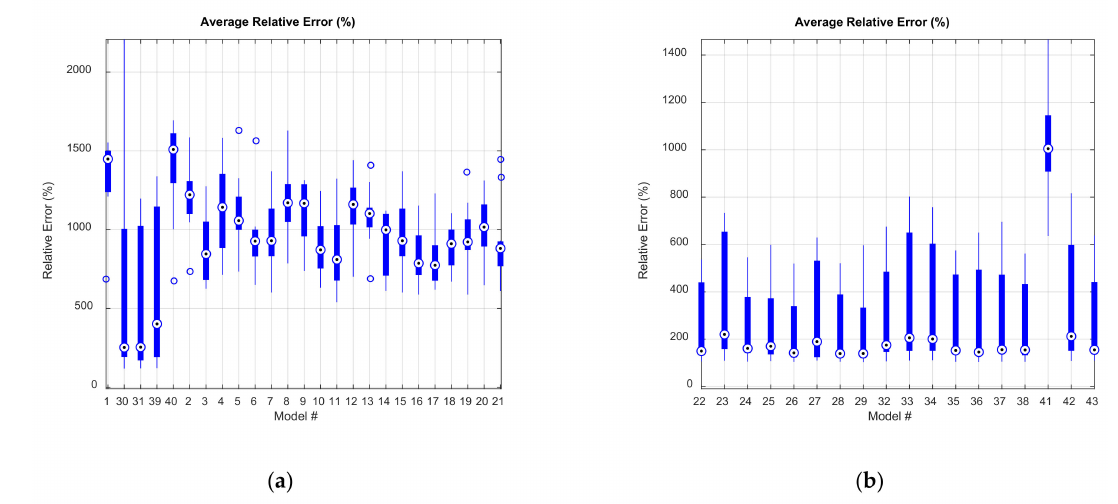
Figure 8. Median average relative errors for all the events analyzed. ( a ) Models without vertical springs at the base; ( b ) models with vertical springs at the base.